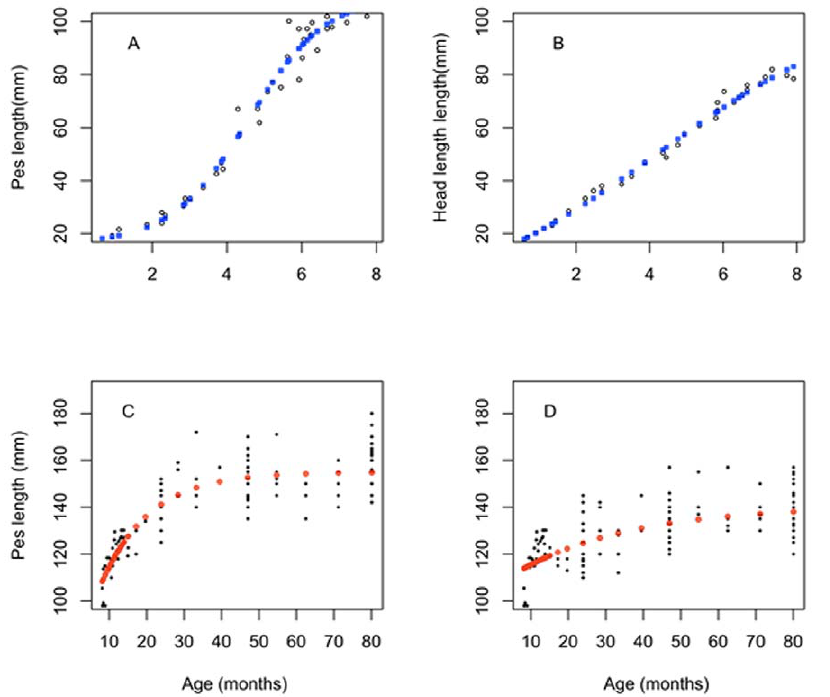
Figure 2. The growth of juvenile Tasmanian pademelons ( Thylogalebillardierii ) during the pouch phase of their life-history. Black circles represent (A) pes length and (B) head length of pouch young (mm); blue squares represent the Verhulst logistic model used to describe (A) pes length and (B) head length growth (mm) during pouch life(Length=A + K.L0/((K 2 L0).e ( 2 r . Age) + L0, r 2 =0.98). Post-weaned pes length growth is represented for(C) males and (D) females, where black circles represent pes length (mm) of pouch young and aqua squares represent the Brody model used to describe post-weaned pes length growth(Eqn.5). Pes Length=A C; L= B . (1 2 C .e 2 k . Age ), r 2 =0.71, and r 2 =0.44 respectively for males and